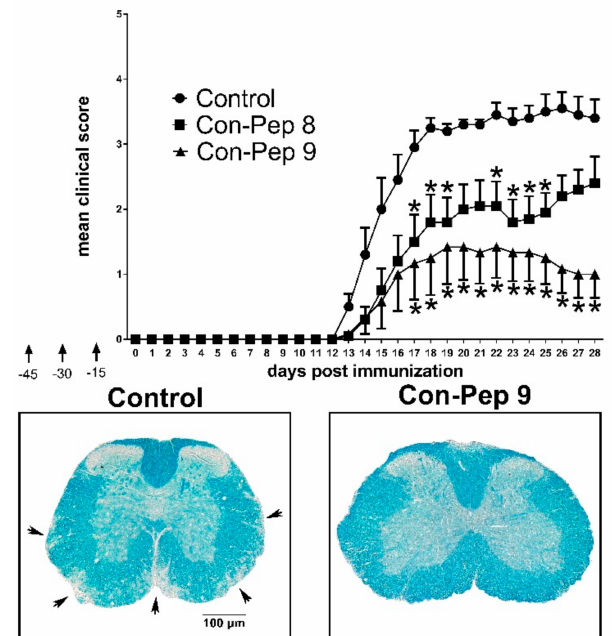
Figure 3. Administration of Con-Pep 8 and Con-Pep 9, conjugated to mannan in its oxidized form, in a prophylactic (vaccination) protocol attenuates the development of MOG-induced experimental autoimmune encephalomyelitis (EAE) in C57BL / 6 mice. Top: Mean clinical scores of MOG-EAE in groups of mice vaccinated intradermally (i.d.) with dilute soluble Con-Pep 8, Con-Pep 9 or carbonate bu ff er pH 9.0 (disease control) at the indicated time points (arrows), prior to the induction of EAE by immunization with MOG / CFA / PTx ( n = 10 for Con-Pep 8 and control groups, n = 6 for Con-Pep 9 group). Bottom: MOG-EAE vehicle control mice induces hallmark demyelinating lesions, as seen by Luxol Fast blue staining of spinal cord sections taken from mice sacrificed on day 28 post-immunization for EAE (left panel, arrows). Vaccination with either Con-Pep 8 (data not shown) or Con-Pep 9 prevented the development of spinal cord demyelination (right panel). Representative sections from three animals per group are shown. Statistical significance after comparisons between Con-Pep 8 and 9 treated